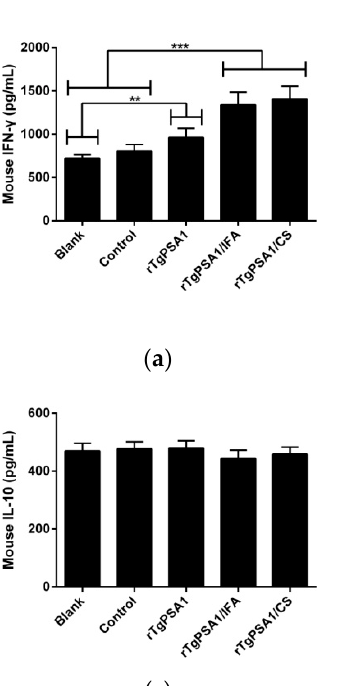
Figure 4. Antibody determination of ( a ) total IgG and isotypes ( b ) IgG1 and ( c ) IgG2 in sera from immunized mice at weeks zero, two, and four. Each sample was conducted once. Values were estimated using one-way ANOVA followed by Dunnett’s test and shown as mean of OD450 ± SD (n = 5). Values between rTgPSA1/IFA and rTgPSA1/CS groups were compared with the independent t -test. * p < 0.05, ** p < 0.01, and *** p < 0.001 compared with blank or control group.